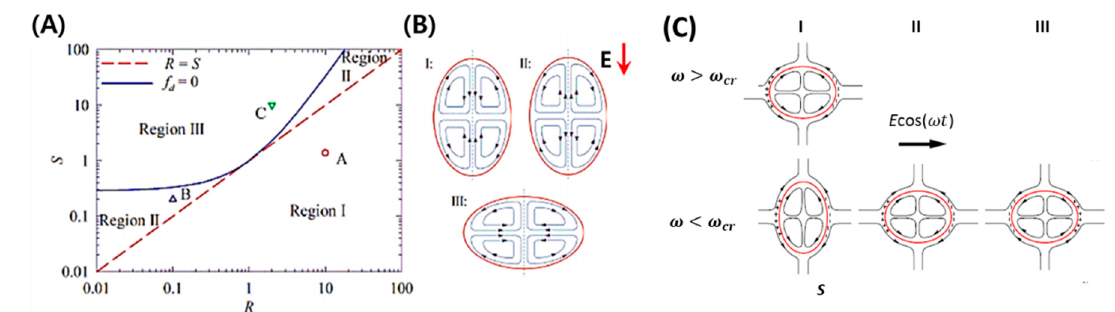
Figure 2. Steady deformation-circulation maps of single-phase emulsion droplet under weak DC/AC electric field. ( A ) Deformation regimes depending on conductivity ratio ( R ), permittivity ratio ( S ), and viscosity ratio ( M ) as predicted by leaky dielectric theory (LDM). ( B ) Flow patterns surrounding the droplet in DC electric field for different regimes as mentioned in ( A ) [68] . ( C ) Flow patterns surrounding the droplet in an AC electric field for different regimes [101] .